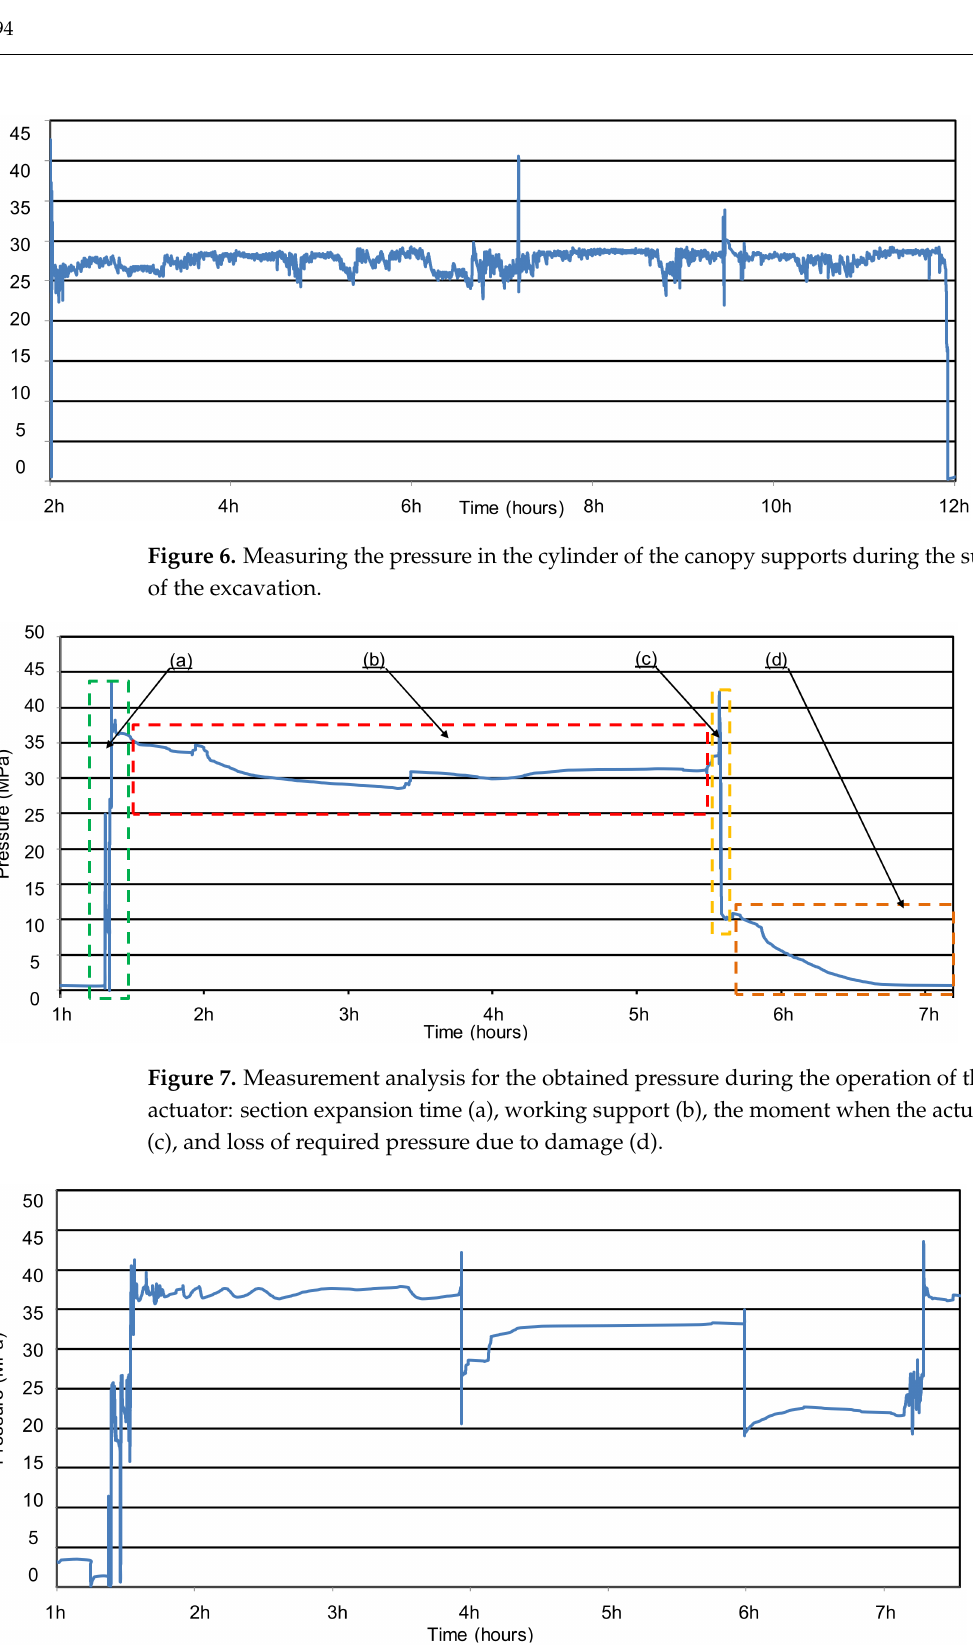
Figure 8. Pressure behaviour during the loading of mechanised casing from the rock